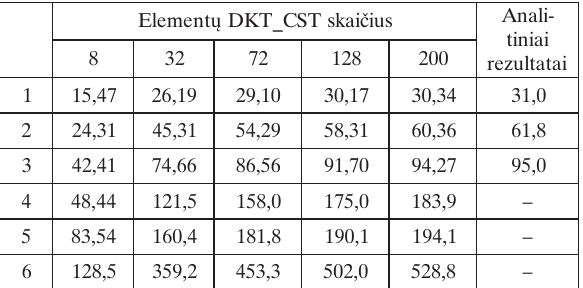
Fig 1. Computational schemas Fig 2. Convergence of the first three eigenfrequencies 1 lentelė. Pirmieji šeši nenuliniai dažniai Table 1. The first six non-zeroes eigenfrequencies